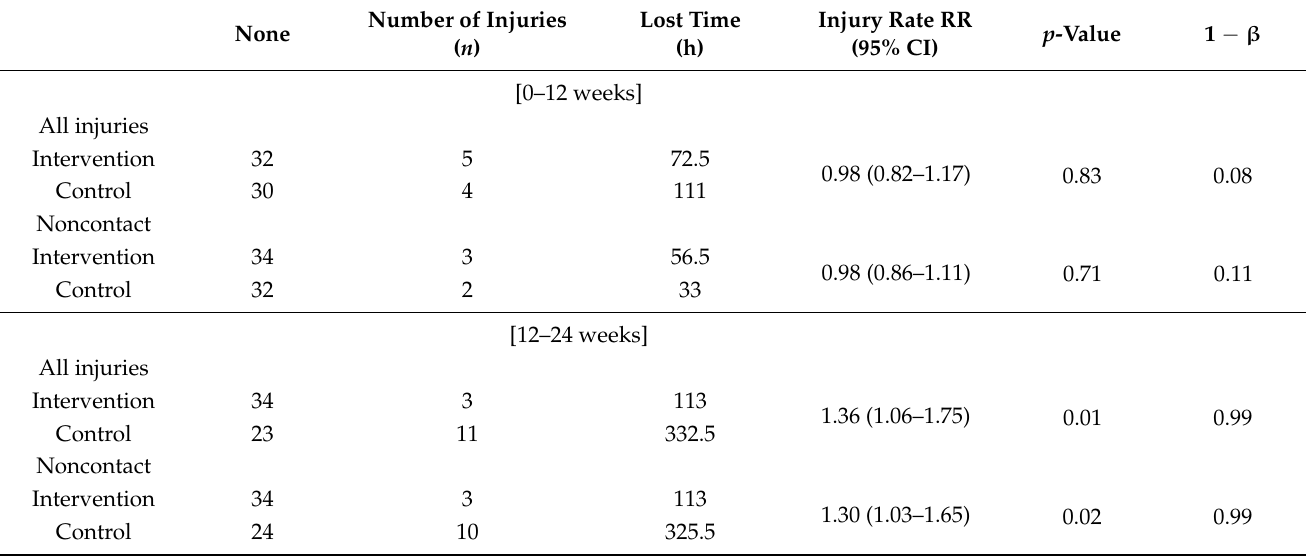
Table 2. Number of injuries, time lost to sports injury, and relative risk.